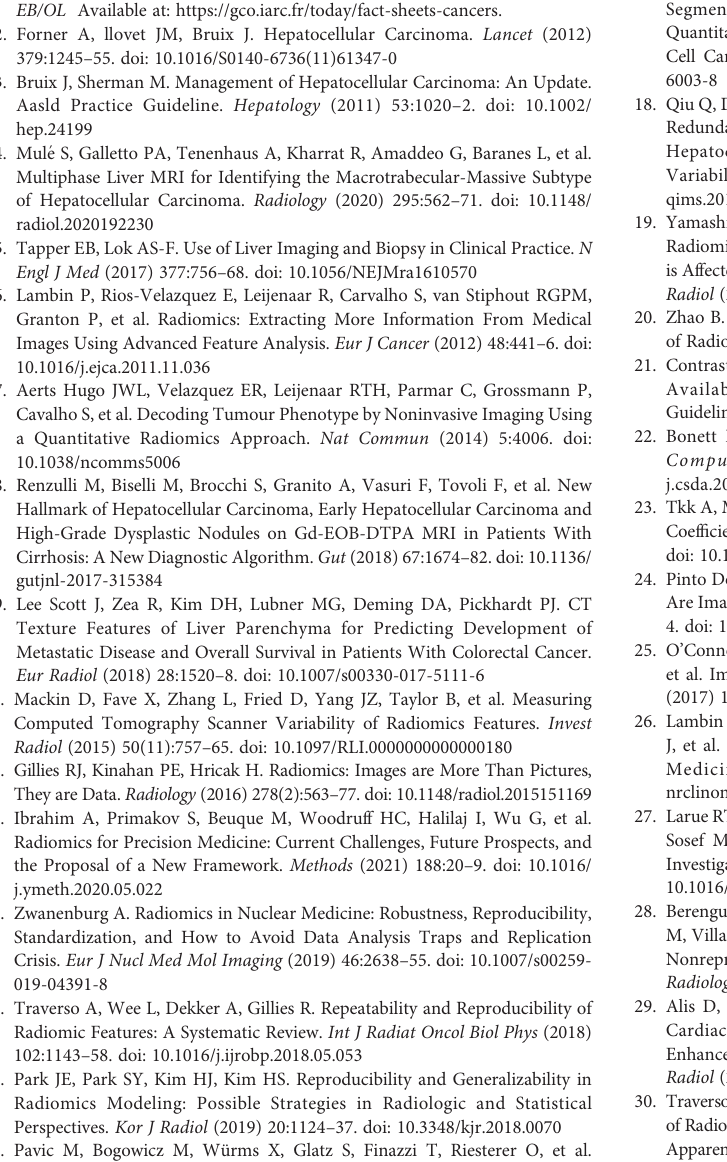
Supplementary Table 1 | The detailed QCD numbers of radiomic features.